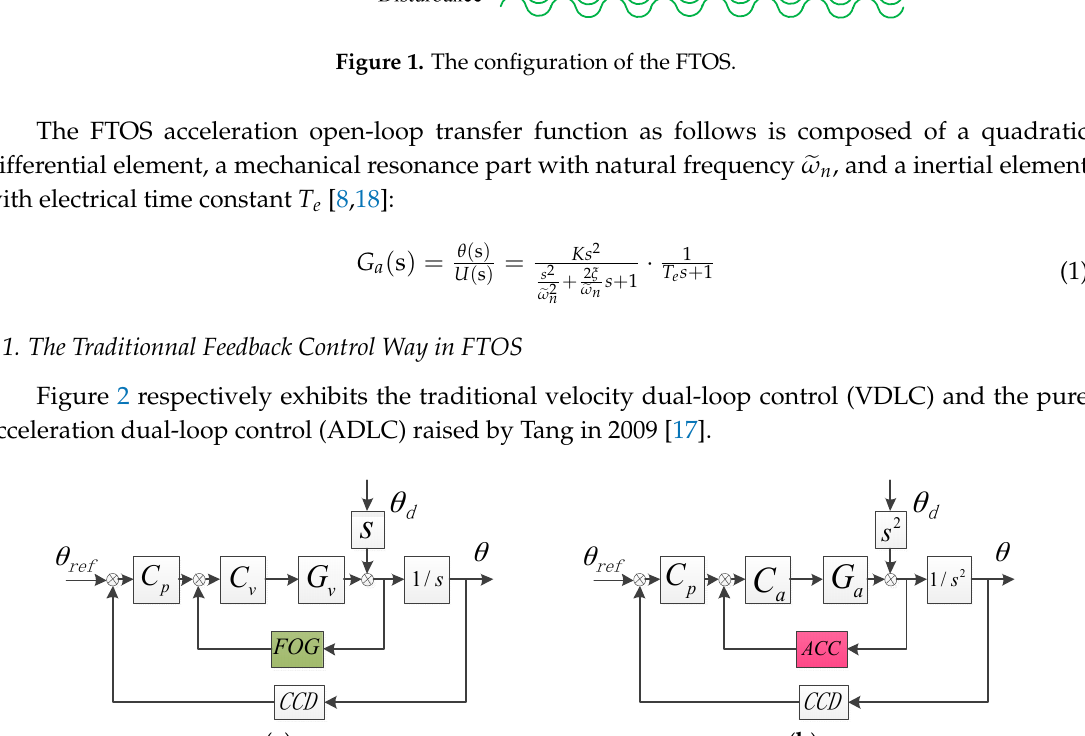
G and G are respectively the velocity v a C , C and v a